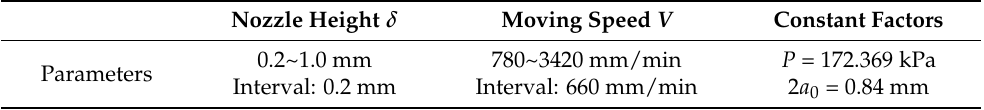
Table 1. Continuous strand printing parameters.